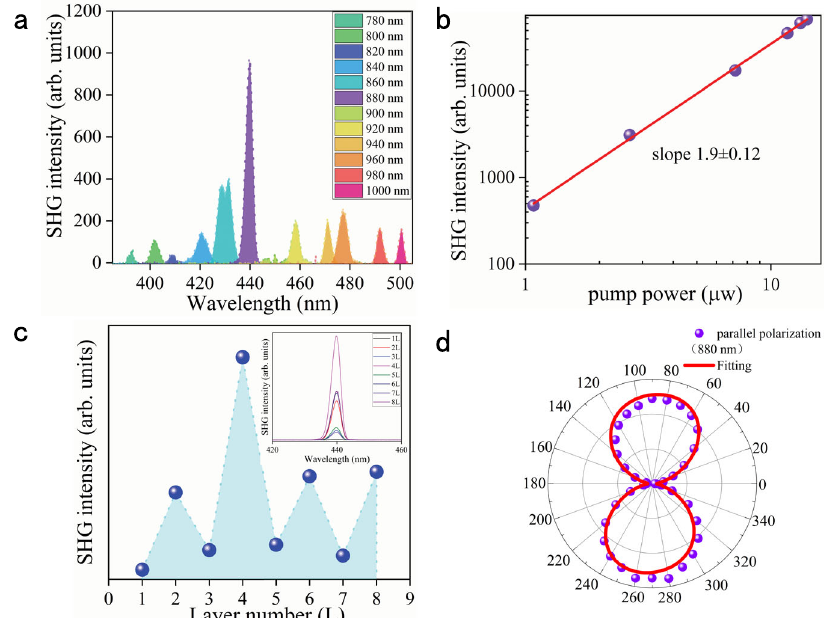
Fig. 4 SHG characterization of the PdSe 2 fl akes. a The SHG intensities excited at various wavelengths from 780 to 1000 nm, represented by different colors. The highest intensity appeared at the wavelength of 440 nm, manifesting the strongest SHG signal of excitation at 880 nm. b The excitation power dependence of SHG intensities in 4 L PdSe 2 . Both axes are shown on the log scale. The correlation of the pump power and SHG intensities exhibits was linear with a slope of 1.9 ± 0.12. c The SHG signal excited at the fi xed wavelength of 880 nm in 1 – 8 L PdSe 2 . The integrated intensity of SHG varied with different layers, represented by the blue dots. The SHG signal was the strongest in the 4 L sample. The inset represents the SHG intensities versus the layer numbers of PdSe 2 . d The purple dots indicate the polar plot of integrated SHG intensities excited by the 880 nm laser in 4 L PdSe 2 . The corresponding fi tting result is denoted by the solid red